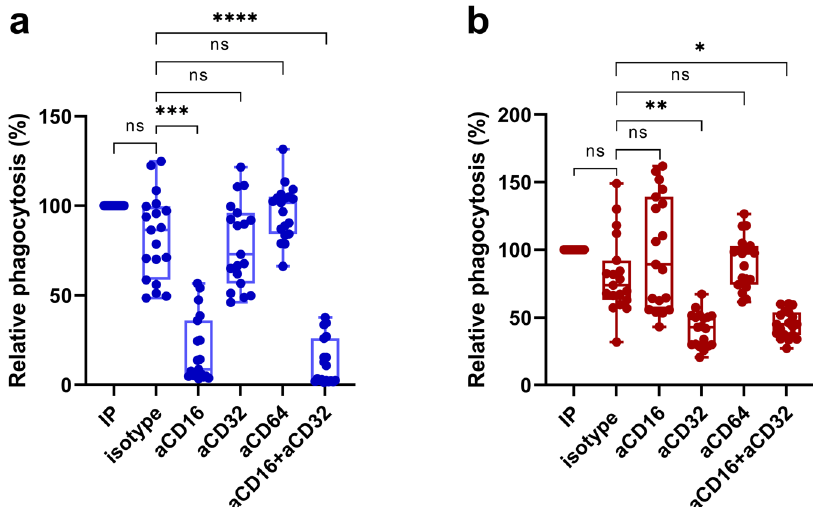
Fig. 3 Phagocytosis of antibody-opsonized merozoites depends on Fc γ RIII in neutrophils and Fc γ RII in monocytes. The PBLs ( n = 19) were treated with 10 µ g/ml of antibodies against CD16, CD32, CD64, or an isotype control for 30 min and then incubated with IP-opsonized merozoites for phagocytosis to occur. Graphs show the relative phagocytosis (%) of speci fi c Fc γ R blocker treated neutrophils a and monocytes b using the untreated homologous phagocytes as reference. Boxes indicate the median and interquartile range. Whiskers mark the minimum and maximum values. P values were determined by the Friedman test and Dunn ’ s multiple comparisons test. Asterisks represent P values (* P < 0.05; ** P < 0.01; *** P < 0.001; **** P <